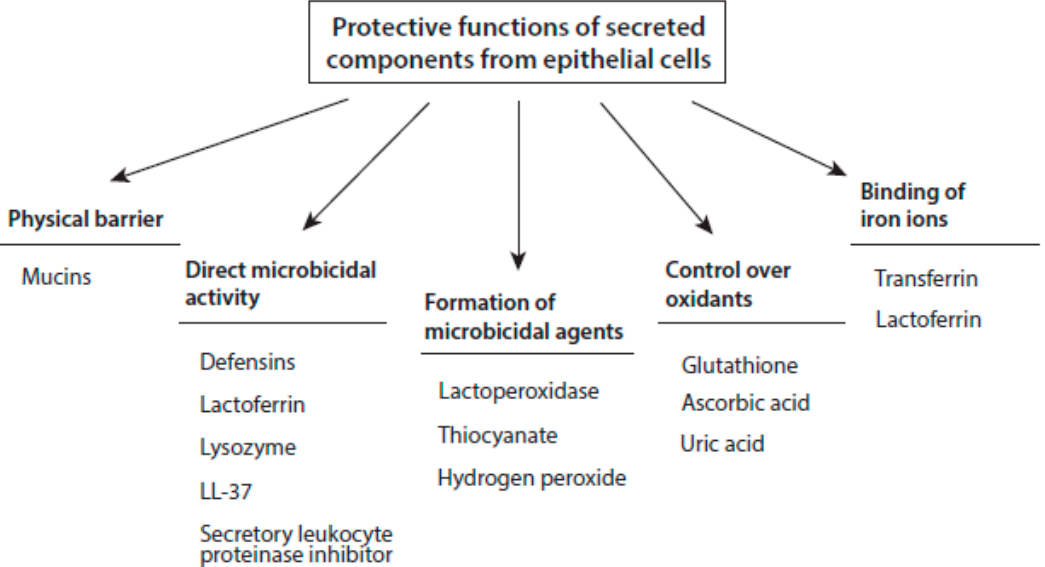
Figure 1. Major immune-protective functions of agents secreted from epithelial cells of mucous surfaces.